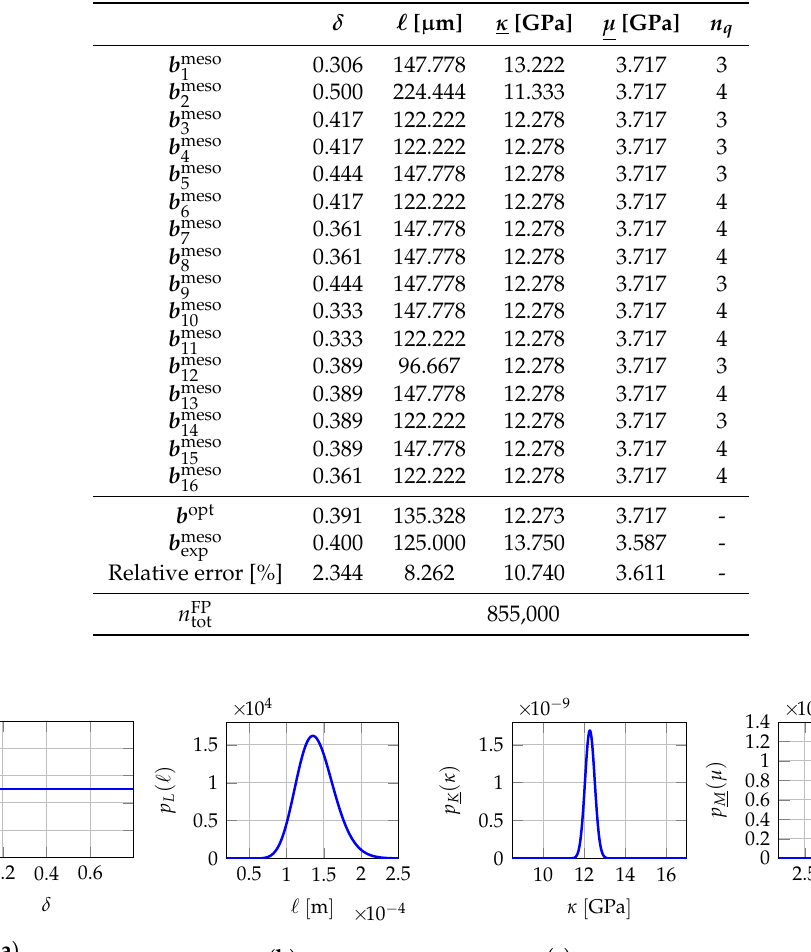
Table 2. Fixed-point iterative algorithm: comparison between the global optimal value b opt obtained from the Q = 16 identified values b meso , . . . , b meso for each of the Q mesoscopic domains of observation Q 1 Ω meso , . . . , Ω meso , and the reference experimental value b meso exp . exp,1 exp, Q